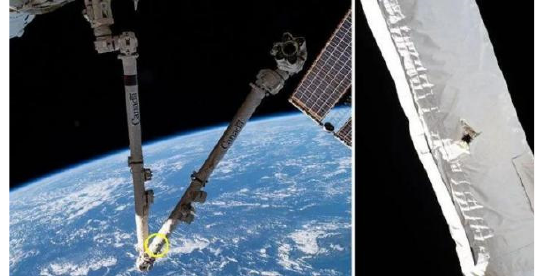
Figure 1. The Canadarm2 hit by space debris (Source: Space.com).